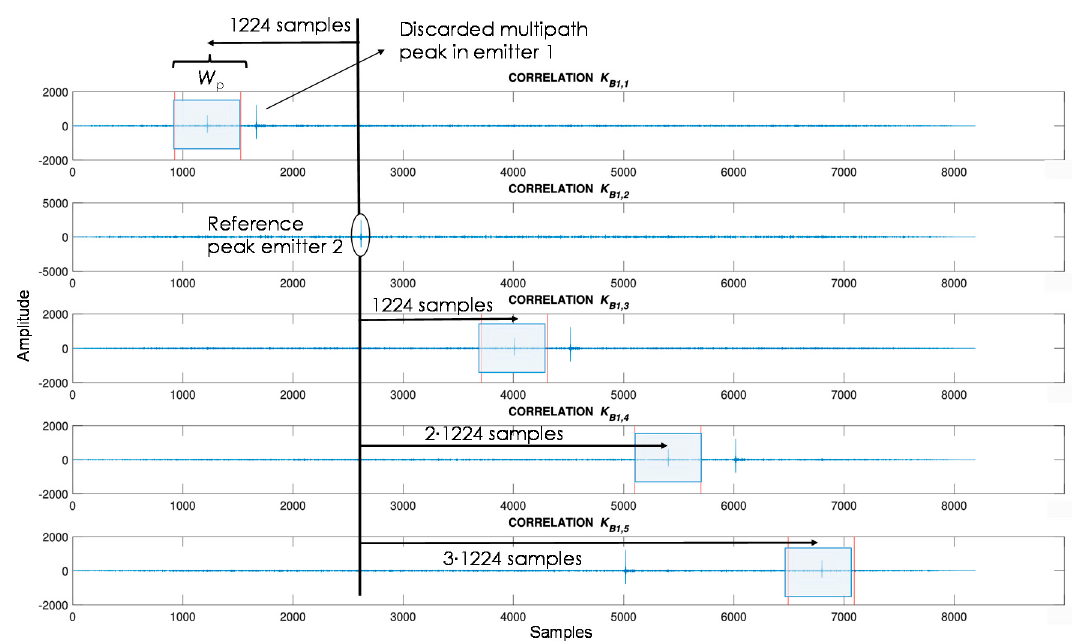
Figure 9. Example of correlation functions from the U-LPS 1 with TDOA ≠ 0.